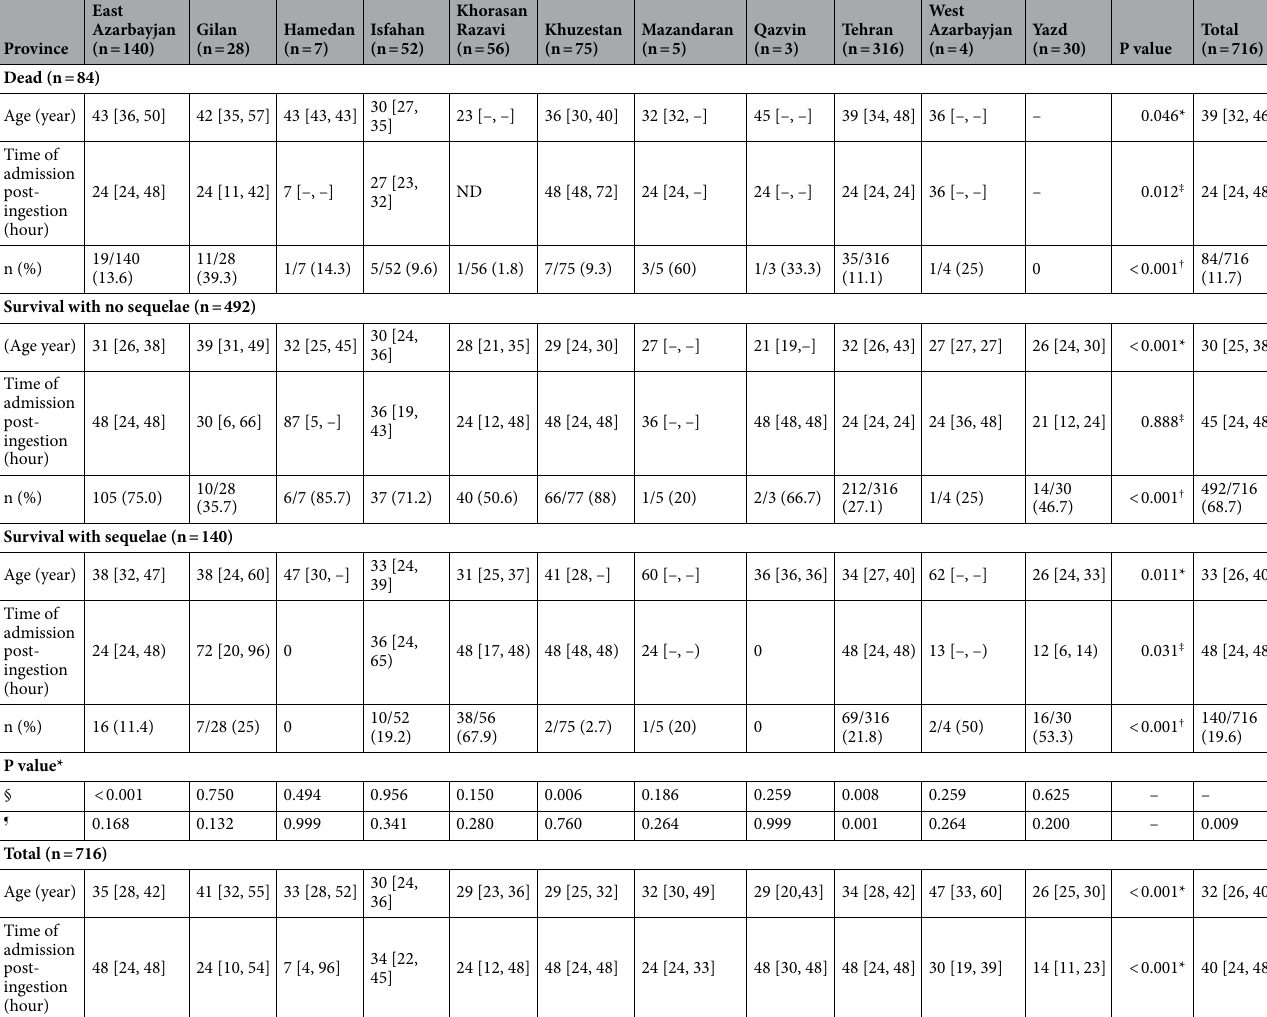
Table 3. Median age and time post-ingestion [IQR] distribution of three major outcomes of 13 toxicology referral centers during early Iranian methanol outbreak (n = 716). ND not defined, Missing data treated by random. *Applying Kruskal Wallis test. † applying Pearson Chi-Square. ‡ Applying Man-Whitney U-test. § Comparing ages in three outcomes. ¶ Comparing time of admission